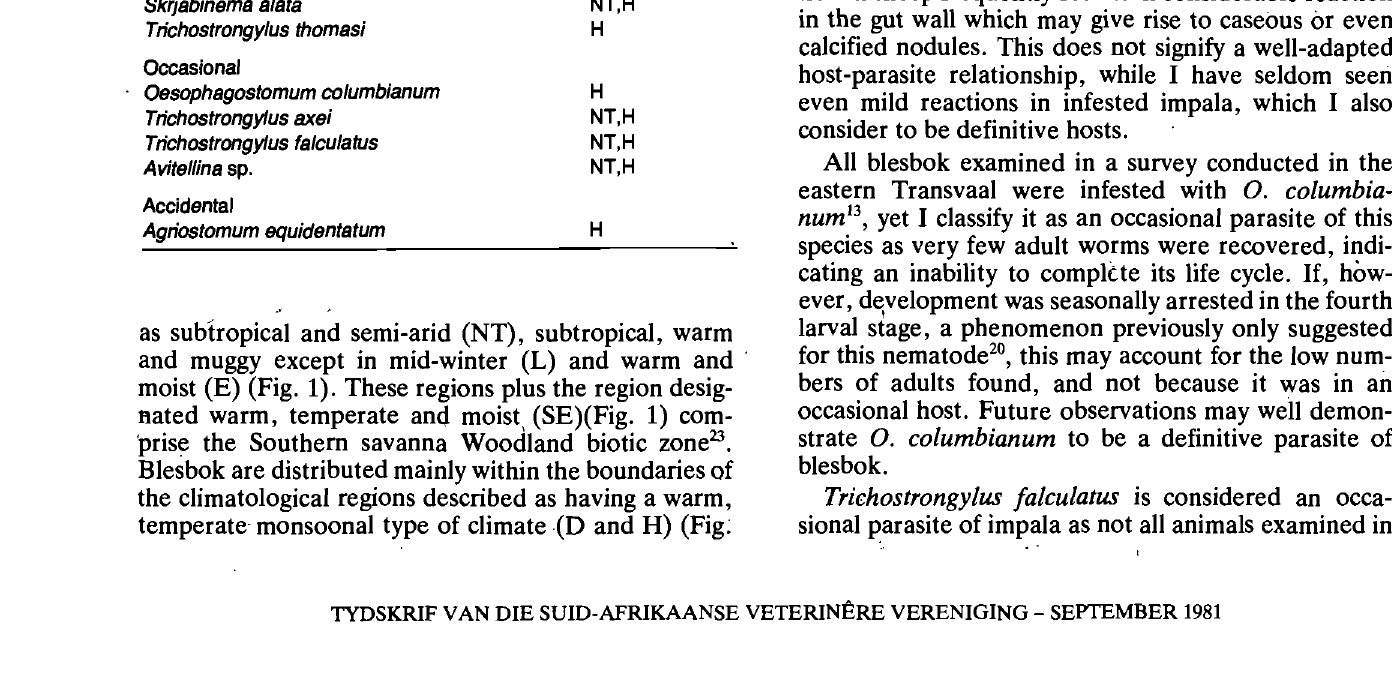
Table 4: DEFINITIVE, OCCASIONAL AND ACCIDEN:rAL HELMINTH PARASITES OF BLESBOK AND THEIR DISTRIBUTION IN THE RSA ACCORDING TO CLIMATE. FOR DISTRIBUTION CODE SEE FIG.